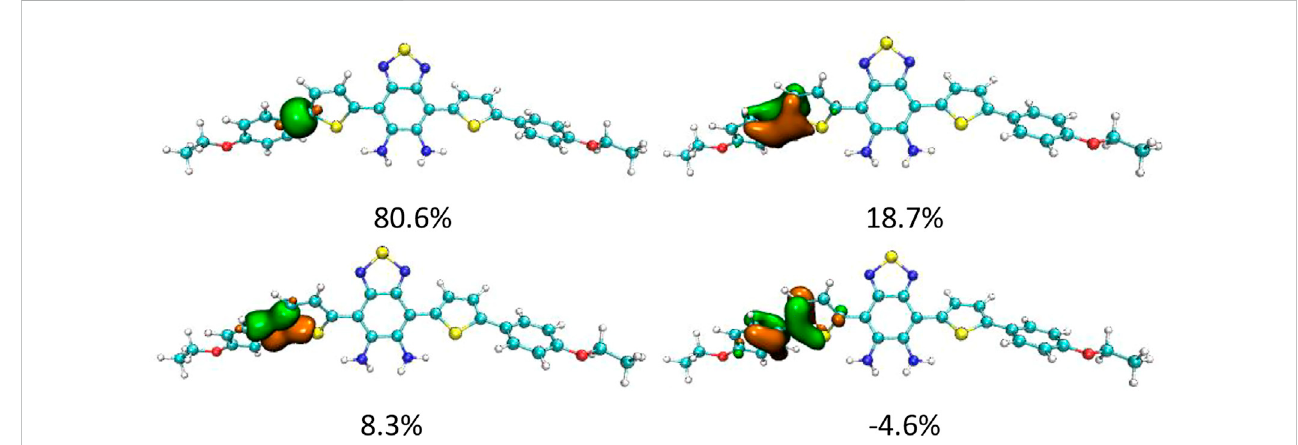
NAdO distribution of the a -related C – C bonds in DAD-NO.